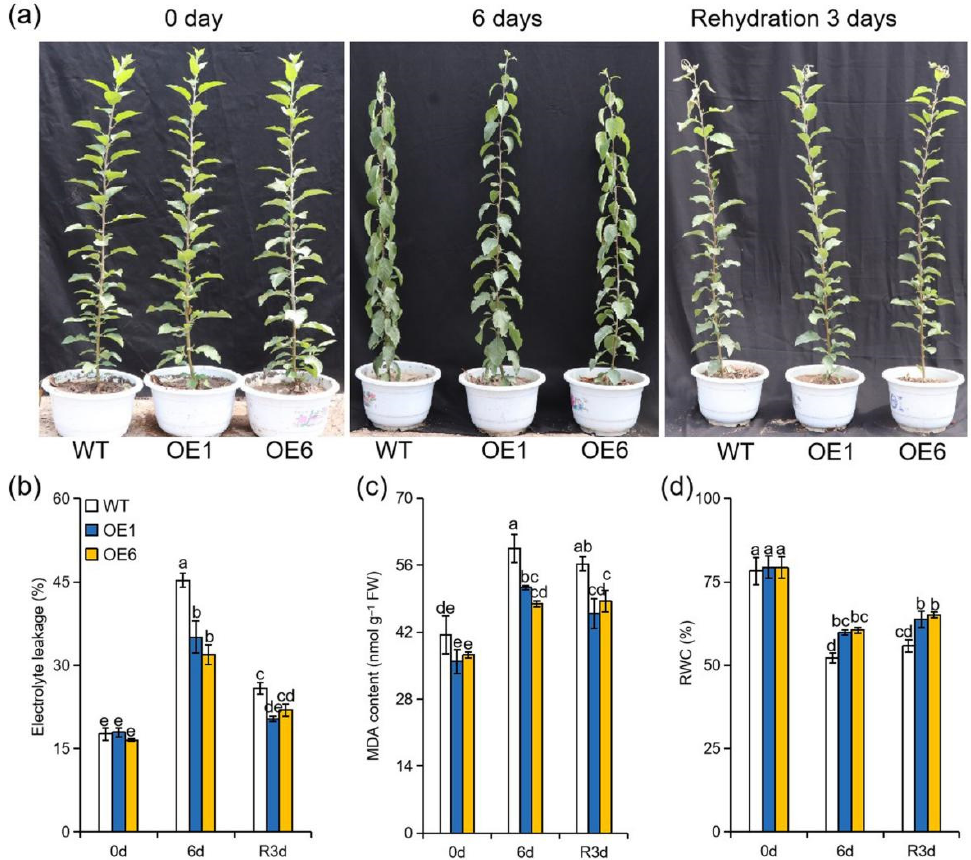
Figure 1. MdATG8i positively regulates drought tolerance. ( a ) Performance, ( b ) relative electrolyte leakage, ( c ) MDA content, and ( d ) RWC in the leaves of MdATG8i OE plants and WT. The data are presented as means ± SD of three replicates. Values with different letters are significantly different ( p < 0.05, Tukey’s multiple range test).